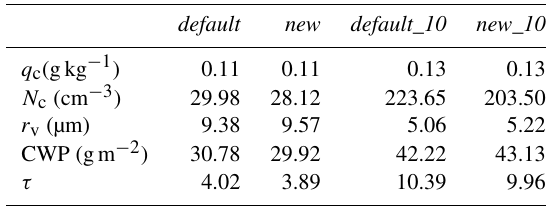
Table 4. Cloud water mixing ratio ( q c ), cloud droplet number con- centration ( N c ), cloud droplet volume mean radius ( r v ), cloud water path (CWP), and cloud optical depth ( τ ) in all simulations for the entire lifetime of the stratocumulus case. The experiments are de- tailed in Table